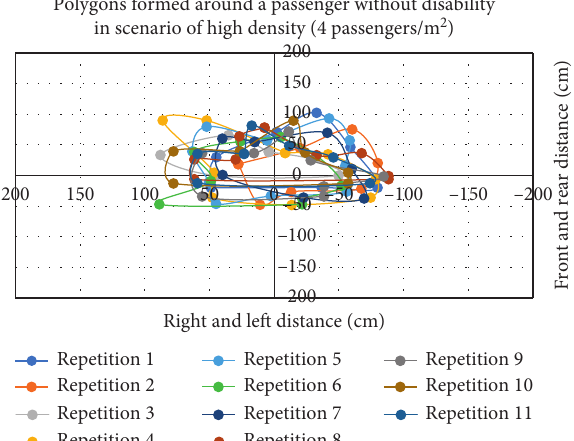
Figure 11: Graphical representation as polygons (measured in cm) of the space occupied by a passenger without disability in each scenario considering the total number of repetitions.